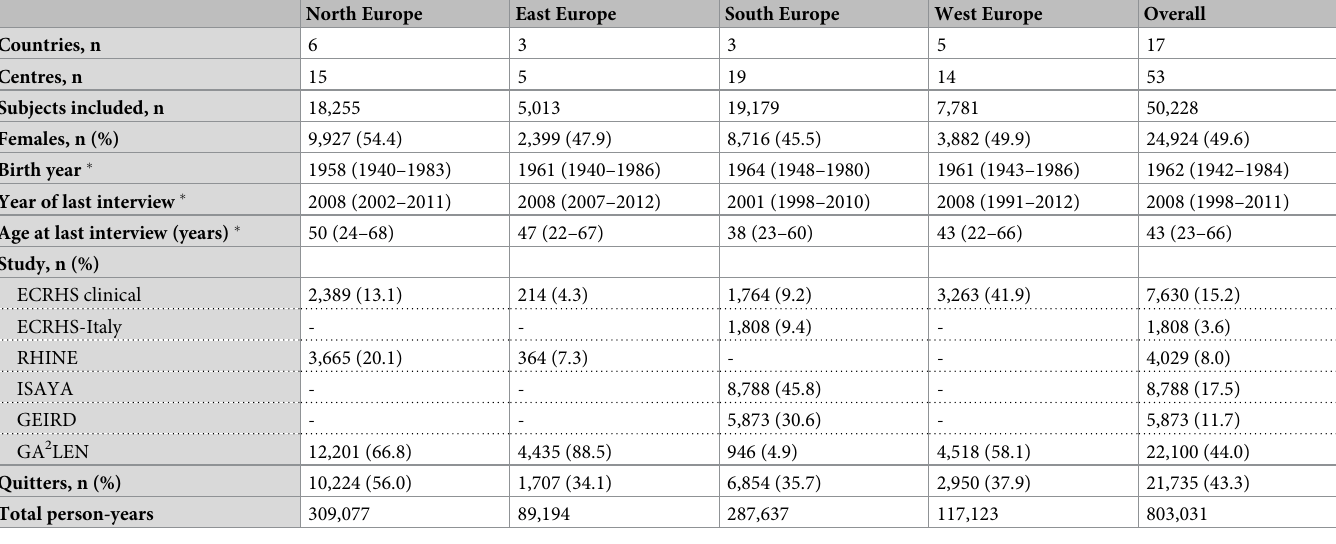
Table 2. Demographic and smoking history data of the subjects included in the analyses, by region. North Europe East Europe South Europe West